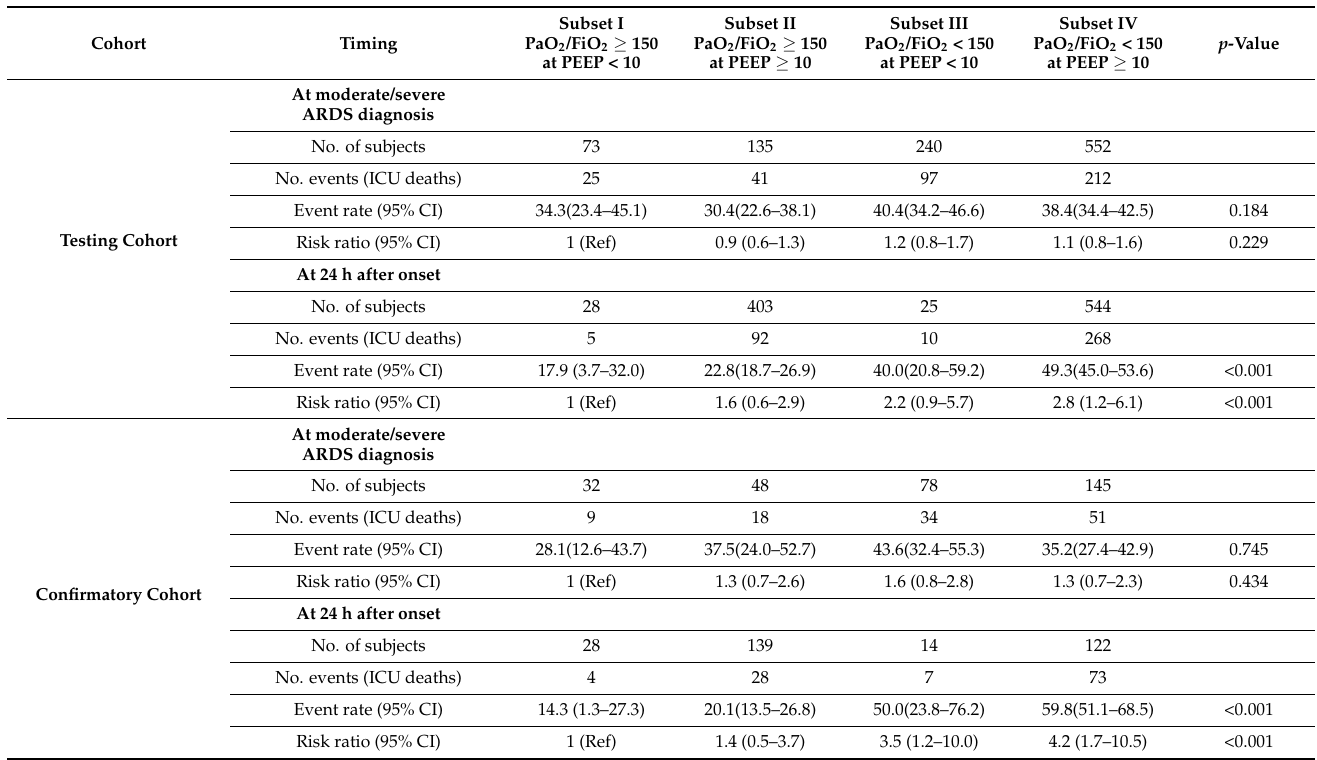
Table 2. Distribution and mortality in the intensive care unit (ICU) of each subset of patients with moderate to severe acute respiratory distress syndrome (ARDS) in the testing ( n = 1000) and confirmatory ( n = 303)